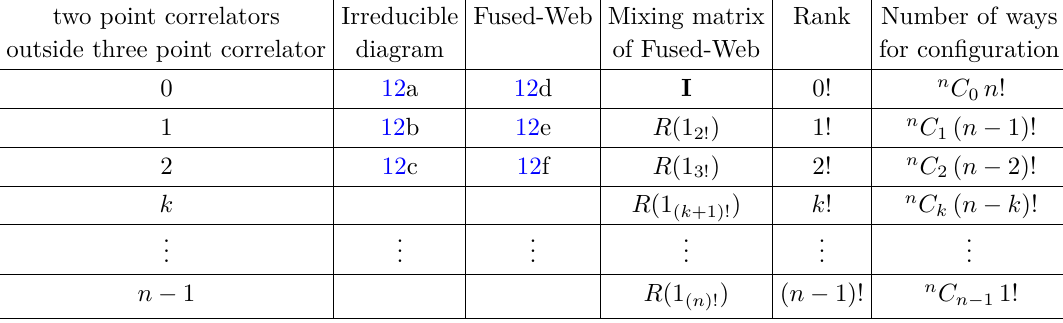
Table 1. Fused-Webs and their mixing matrices for Cweb W ( n +1)